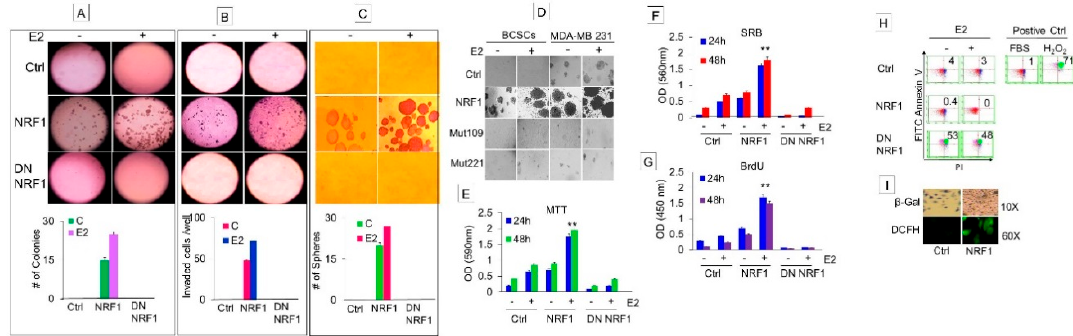
Figure 2. Phenotypic characteristics and growth properties of estrogen-induced tumor initiating breast cancer cells. Phenotypic properties of transformed breast epithelial cells of MCF10A [MCF-10A (T); breast tumor initiating cells with CD24 and CD44 signature (BTICs); breast cancer stem cells (BCSCs)] overexpressing vector (control), NRF1, or DN NRF1 treated with DMSO and E2 were assessed for anchorage-independent growth ( A ), migration and invasion ( B ), and mammospheres ( C ). Bottom panels of A, B, and C show quantitative changes in colonies, invaded cells and mammospheres in vector, NRF1 and DN NRF1 treated with DMSO (control) and E2 at 14 days, respectively. ( D ) Inhibition of mammosphere formation of BCSCs by NRF1 mutants 109 and 221 at 14 days. Growth of BCSCs overexpressing vector (control), NRF1, or DN NRF1 treated with DMSO and E2 measured by assessing metabolic capacity by the MTT assay ( E ); cellular protein content by sulforhodamine B (SRB) ( F ); DNA synthesis by BrdU incorporation assay ( G ). FACS analysis after FITC Annexin V ( X -axis) and propidium iodide (PI: Y -axis) staining for apoptosis ( H ) and senescence by SA- β -gal activity histochemically ( I ) of BCSCs overexpressing vector (control), NRF1, or DN NRF1 treated with DMSO and E2. Error bars represent the mean of three independent experiments ± SD. ** p < 0.01 vs. control.